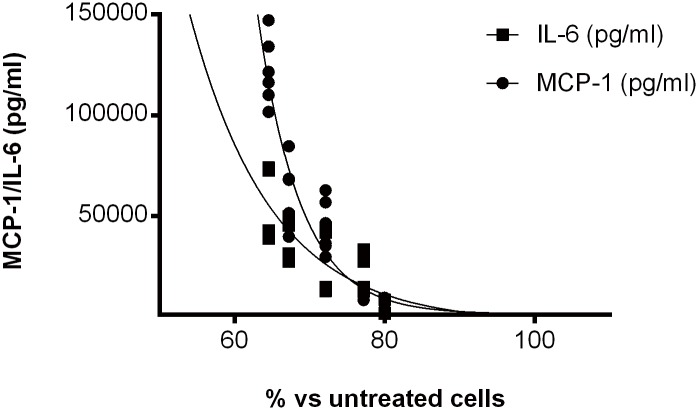
Relationship between cell death and cytokine concentrations.hUC-MSCs of different reactive clones (2x104 in 96-well plates) were stimulated with TNF-α (20 ng/ml, 1.1 nM), TRAIL (500 ng/ml, 28 nM) alone or in association with TNF-α or TNF-α associated with IFN-γ (50 ng/ml, 3 nM) for 48h. Then, cell death was scored by CellTiter-Glo Luminescent Cell Viability Assay and expressed as % of control untreated cells. A statistically significant one-phase decay was observed for both IL-6 and MCP-1 with r2 = 0.74 and 0.92 respectively.